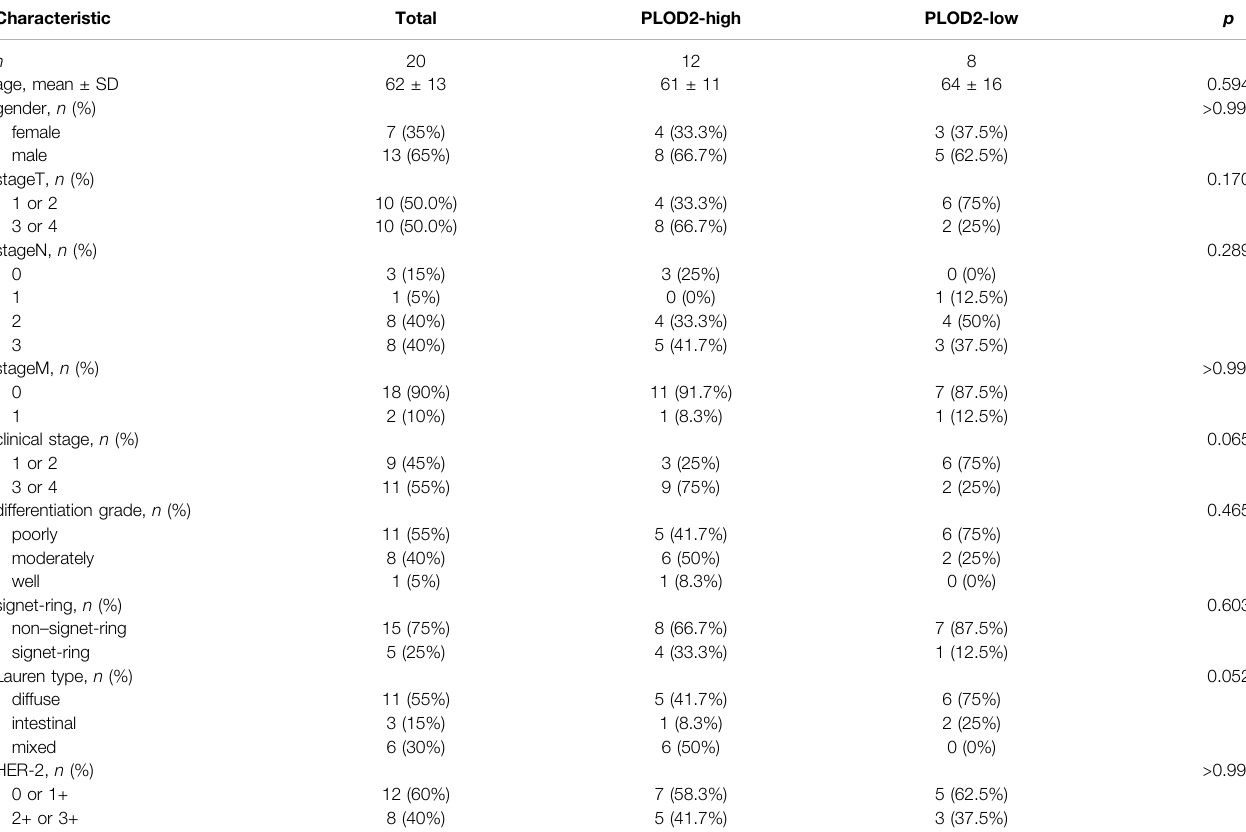
TABLE 3 | Relationship between PLOD2 expression and